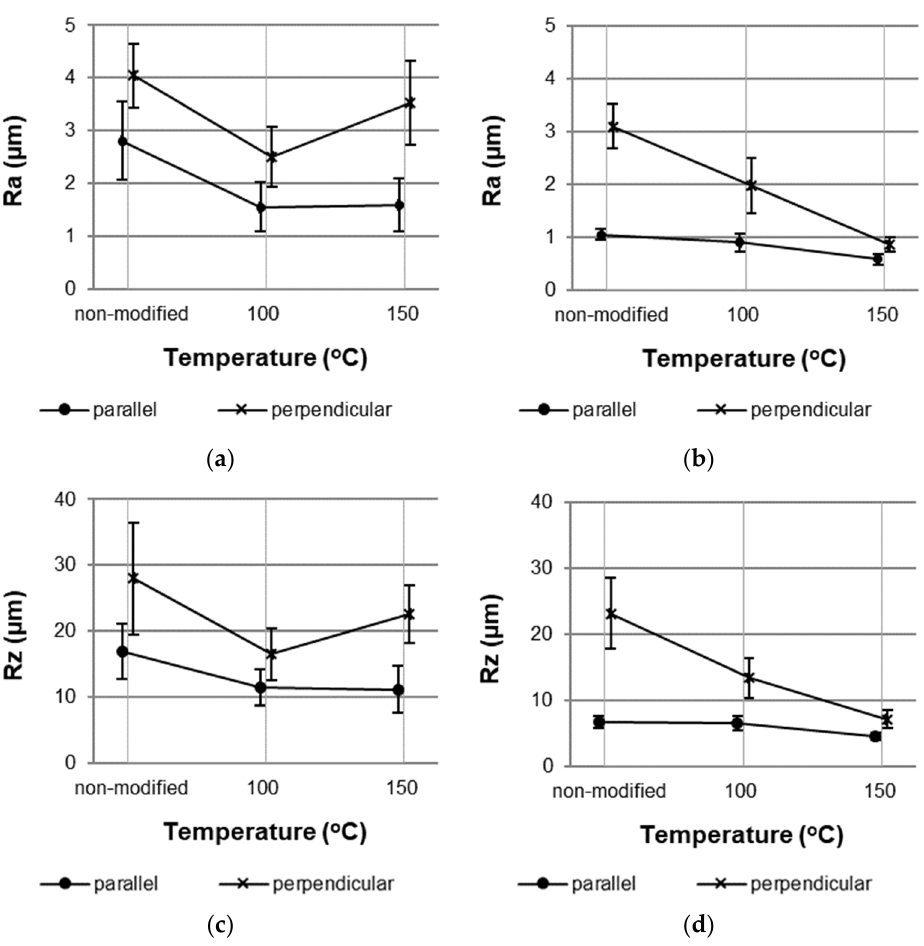
Figure 3. Roughness parameters of ( a ) Ra and ( c ) Rz of iroko wood and ( b ) Ra ( d ) Rz of tauari wood.